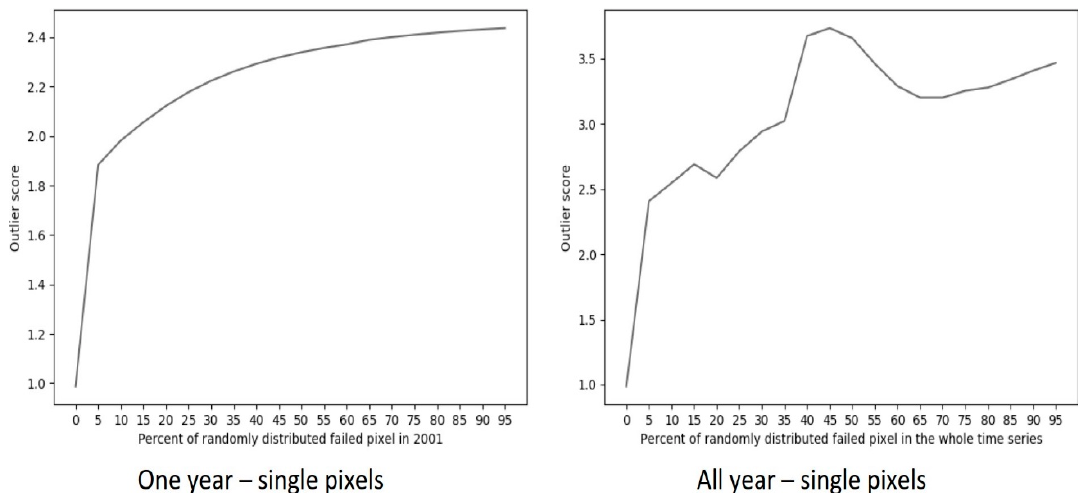
Figure 2. Local outlier scores estimated for synthetic data with random pixels failed in one year ( left ) or all years ( right ).